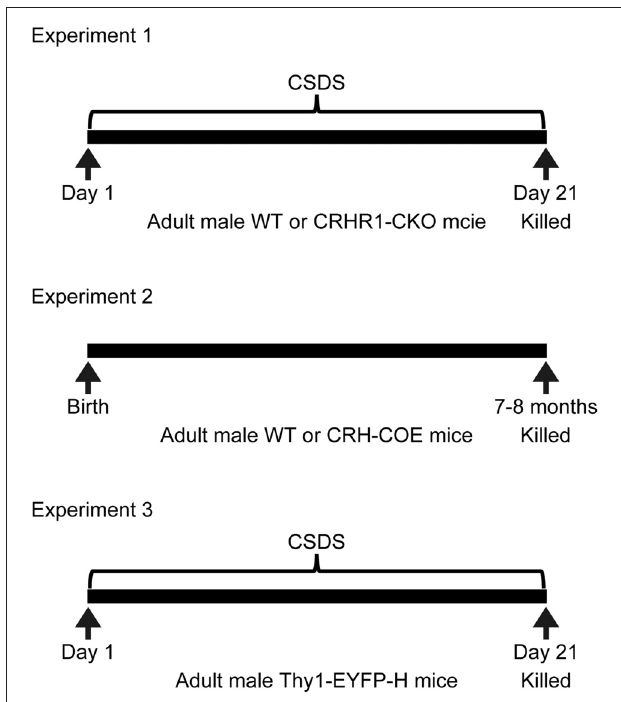
FIGURE 1 | Experimental design. CRHR1-CKO, corticotropin-releasing hormone receptor 1-conditional knockout; CRH-COE, corticotropin-releasing hormone-conditional overexpression; CSDS, chronic social defeat stress; EYFP, enhanced yellow fluorescent protein; WT,